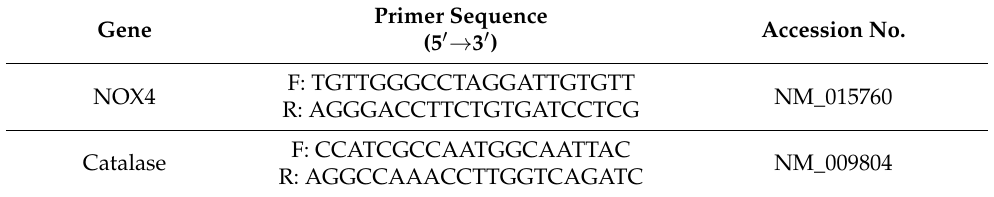
Table 1. List of